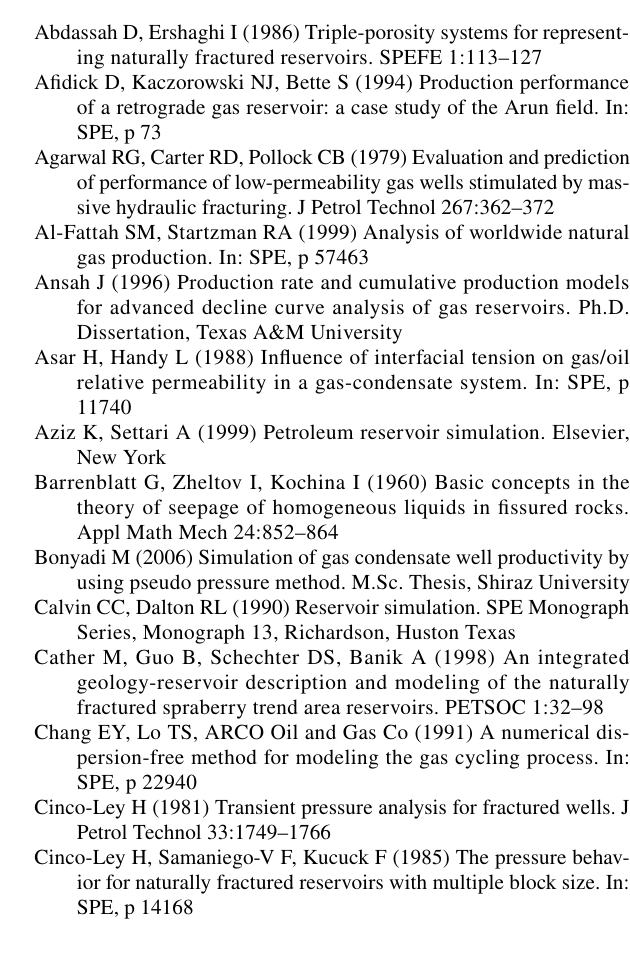
Fig. 19 Cylindrical gridding system of well #1, case #1